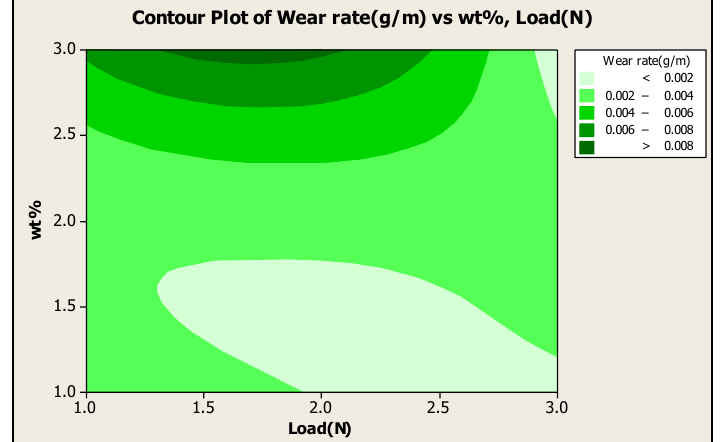
Figure 15: Contour plot of wear rate against weight % and load at low speed. Source: Authors, (2022).